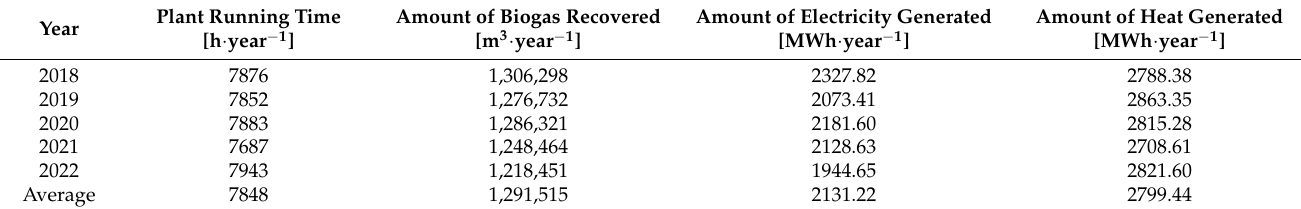
Table 3. CHP plant performance data for